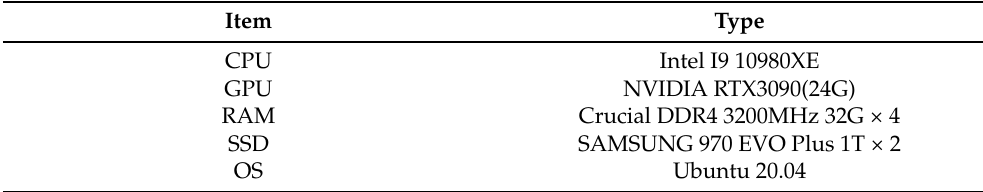
Table 3. Computer hardware information.